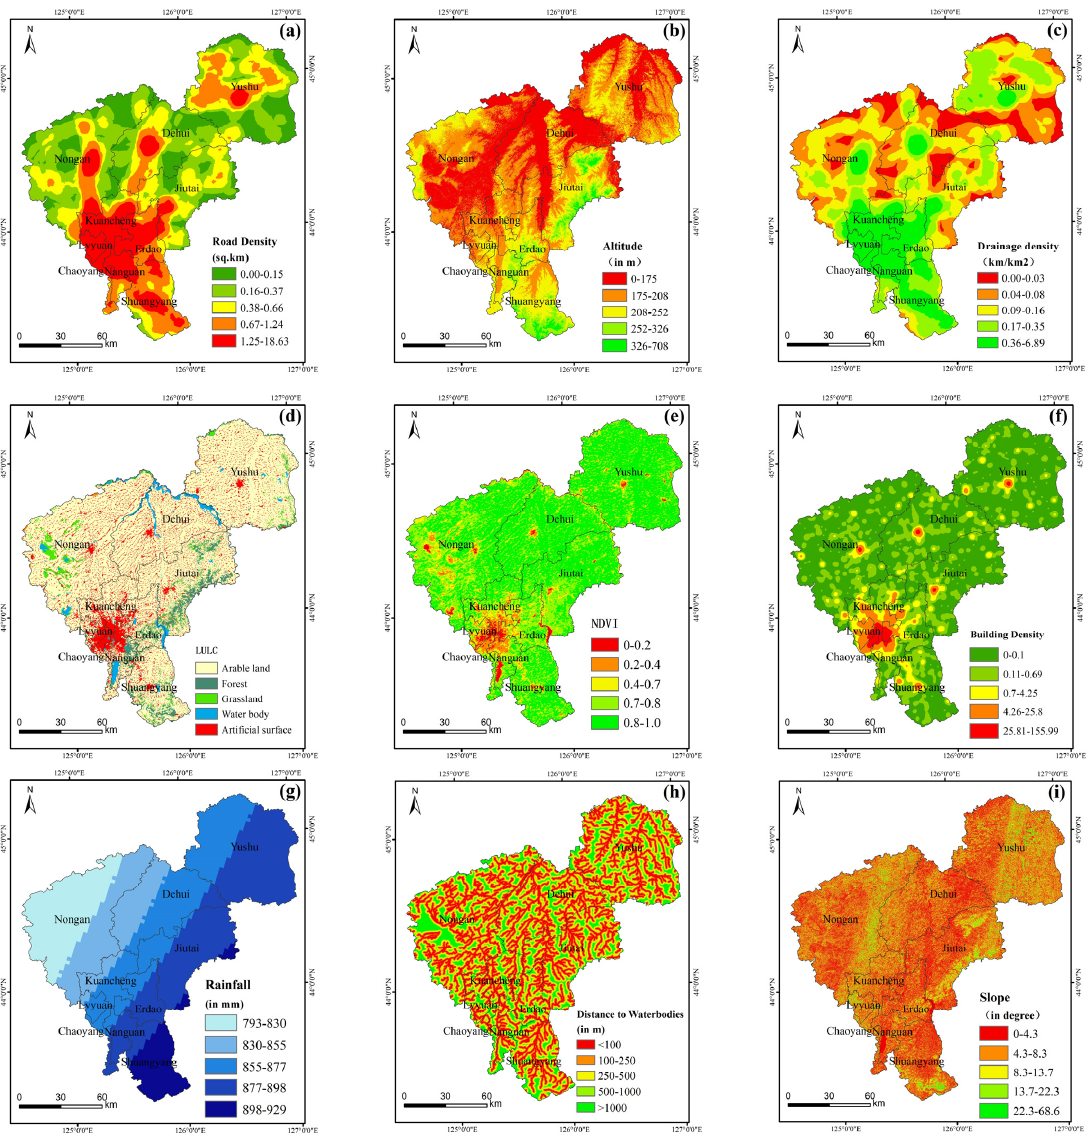
Figure 3. Spatial distribution map of infrastructure and environmental indicators: road density ( a ); altitude ( b ); drainage density ( c ); LULC ( d ); NDVI ( e ); building density ( f ); rainfall ( g ); distance to water bodies ( h ); slope ( i ).